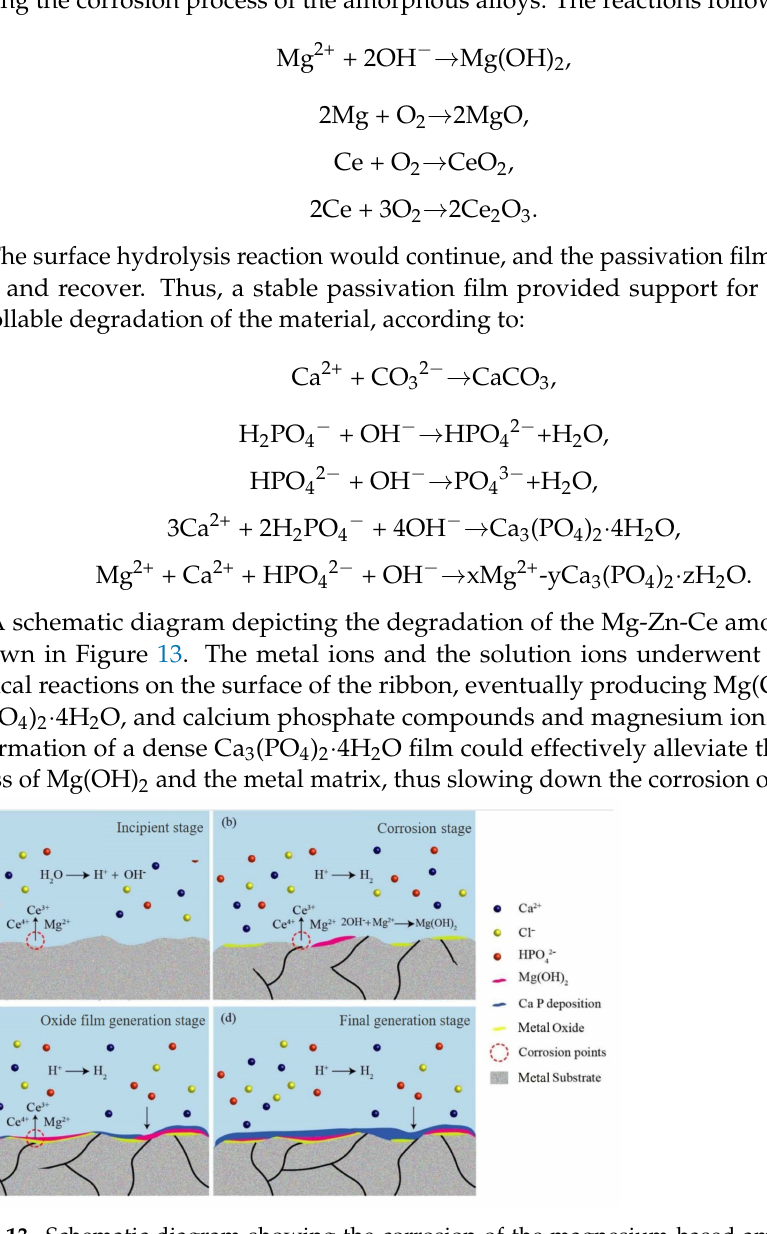
Figure 13. Schematic diagram showing the corrosion of the magnesium-based amorphous alloy immersed in SBF. ( a – d ) Representation of the gradual corrosion